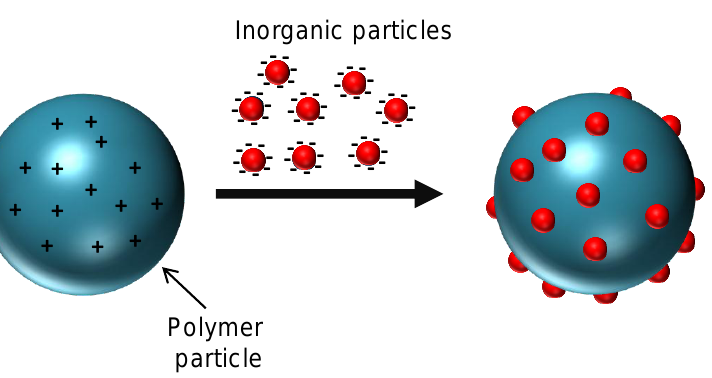
Figure 5. Heterocoagulation of oppositely charged